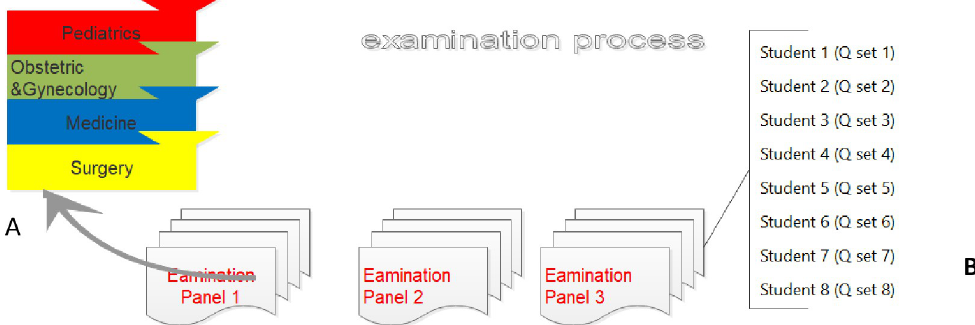
Fig 2. Examination process. (A) Sequence of discipline questions asked by examination panel, (B) question sets according to assigned students numbers in each examination panel i.e. 8 set of questions used by each examination panel for the 8